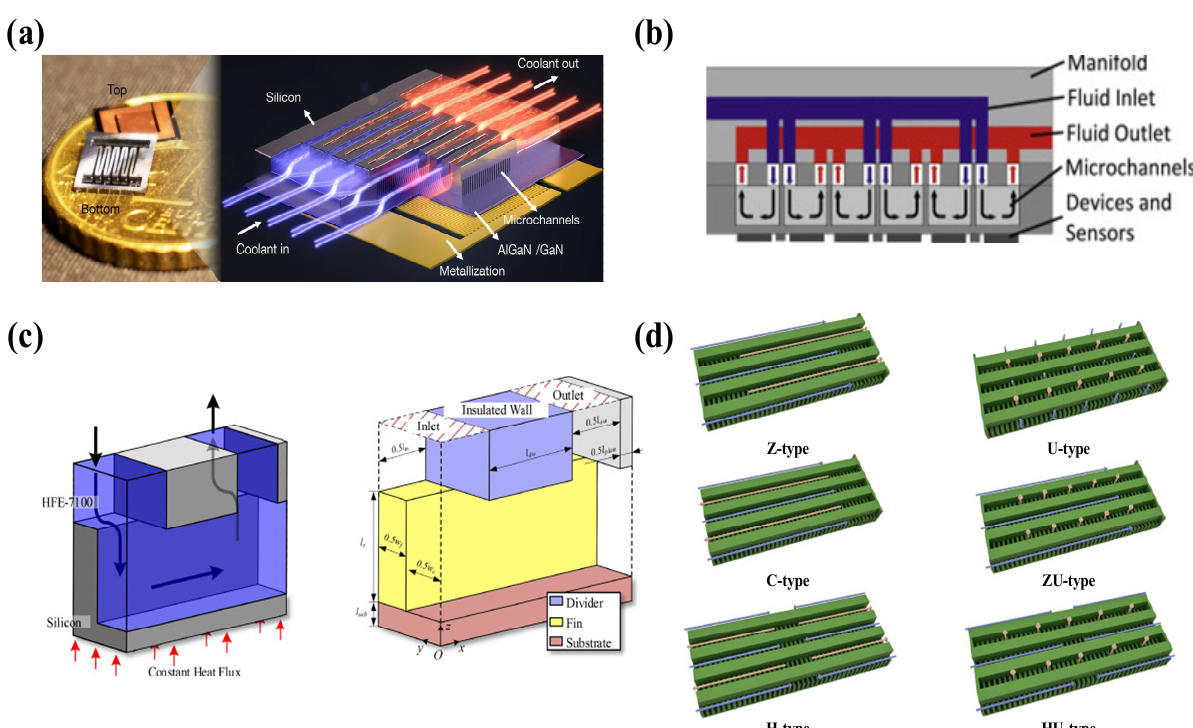
Figure 20. Schematic diagram of manifold microchannel: ( a ) Erp et al. (adapted from Ref. [130]), ( b ) Drummond et al. (adapted from Ref. [131]), and geometry optimization of manifold microchannel, ( c ) Luo et al. (adapted from Ref. [134]), ( d ) Lin et al. (adapted from Ref. [136]).